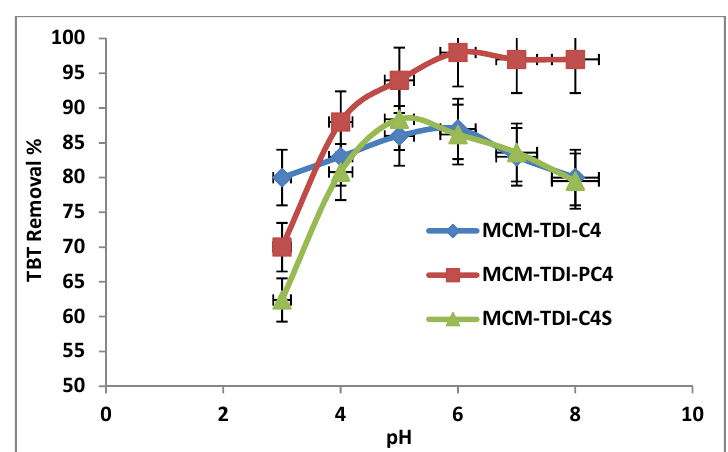
Figure 5. Effect of pH on removal of